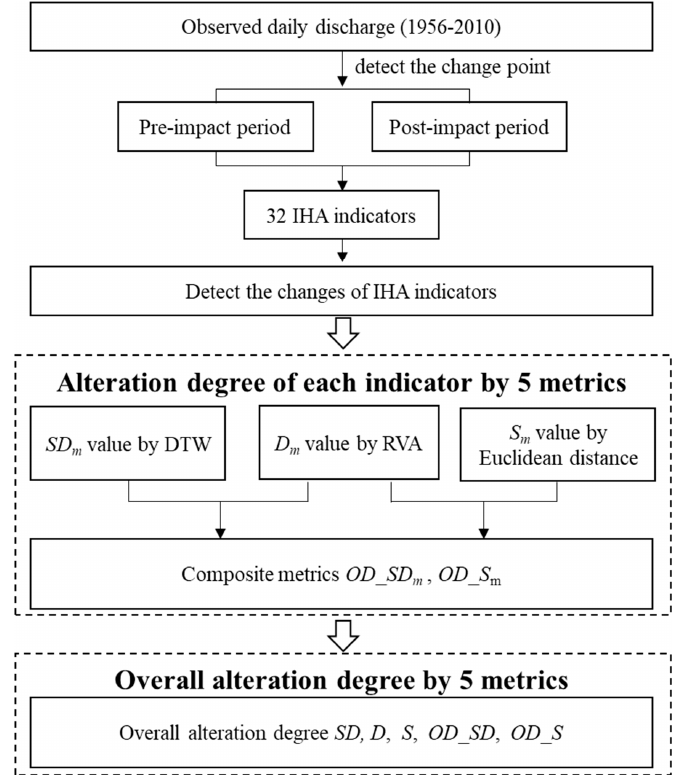
Figure 2. Overall procedures for assessing flow regime alteration.